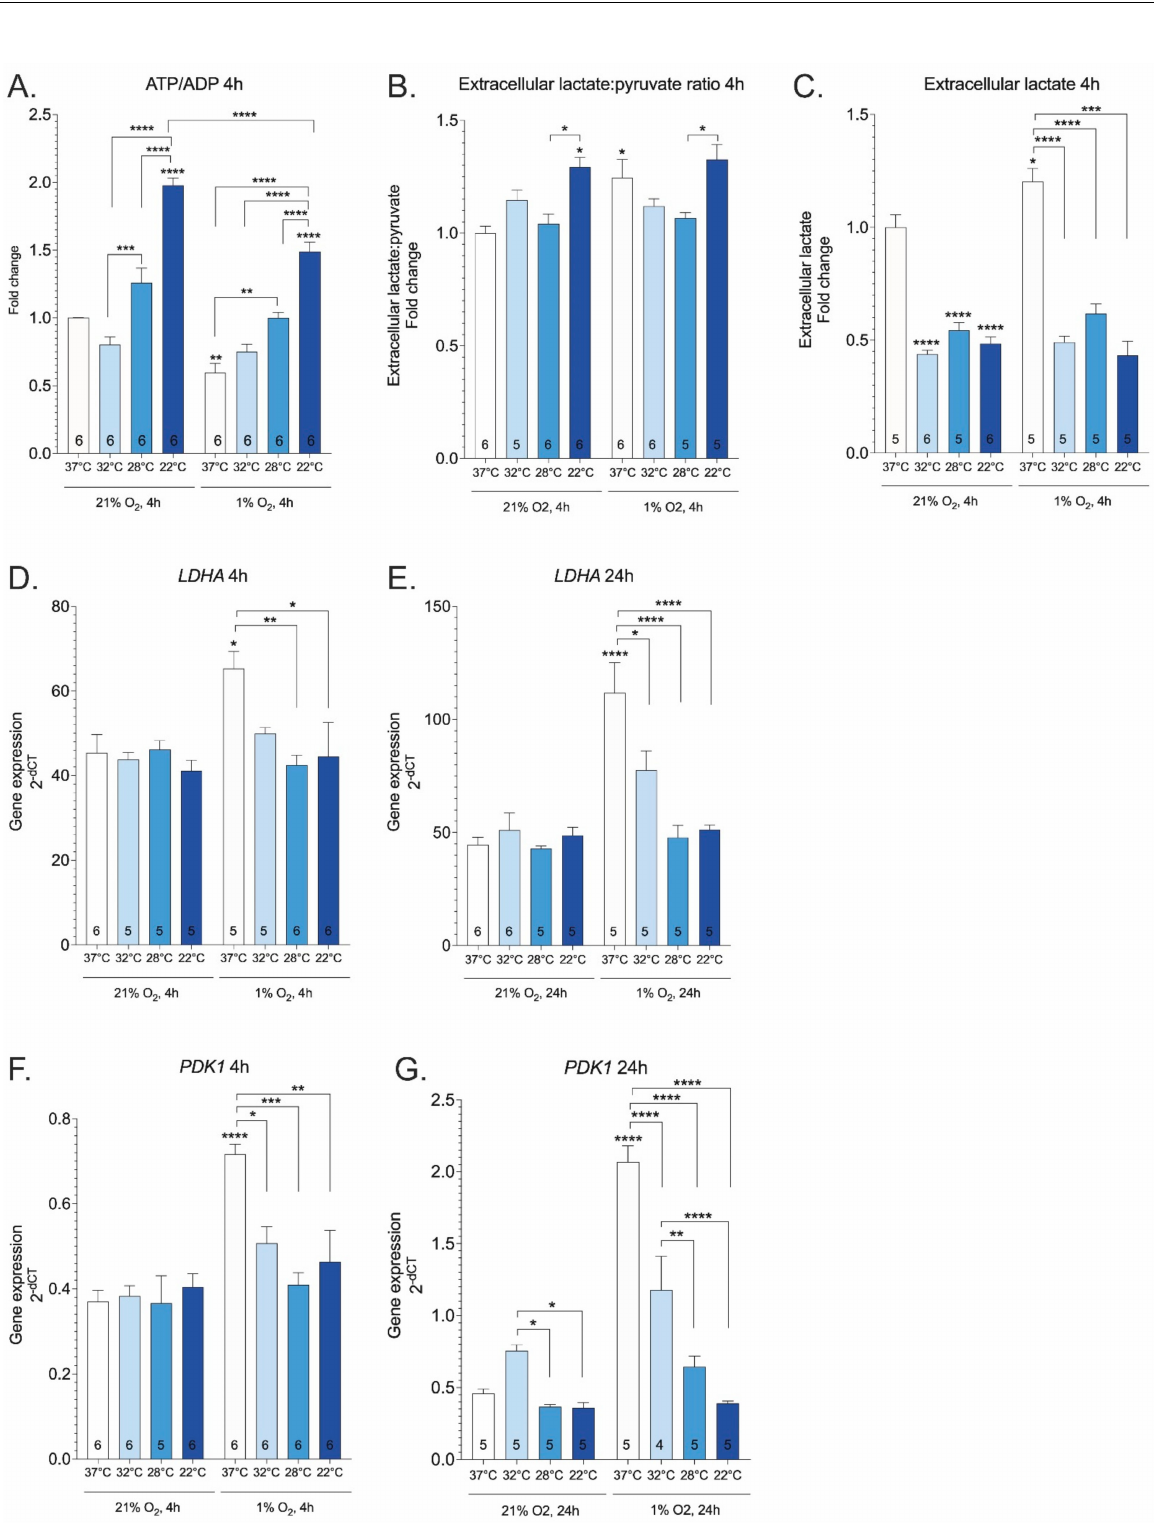
Figure 2. Ratio of ATP to ADP ( A ), ratio of extracellular lactate to pyruvate ( B ), extracellular lactate levels ( C ), and gene expression of LDH-A ( D , E ) and PDK1 ( F , G ) at various temperatures and oxygen concentrations. Treatments were performed for 4 or 24 h. Results are normalized relative to 37 ◦ C group ( A – C ). Asterisks refer to a statistically significant difference with respect to 37 ◦ C control unless indicated otherwise. Numbers in bars indicate sample size. Values are expressed as mean ± SEM. Statistical analysis was performed with One-way ANOVA with post-hoc Tukey HSD Test. *, p < 0.05; **, p < 0.01; ***, p < 0.001; ****, p <